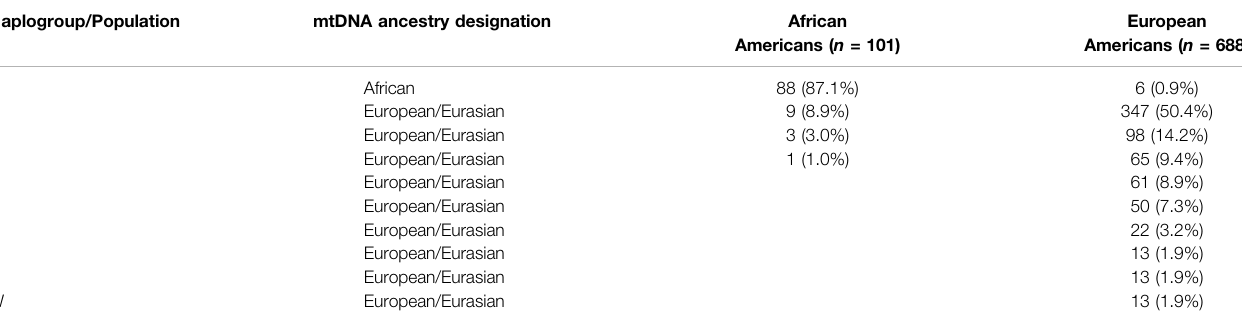
TABLE 1 | MtDNA haplogroup designations for genotyped African Americans and European Americans utilized in the study. The haplogroups are listed in the order of decreasing numbers in the overall dataset. In parentheses is the percentage from the total number of each population. We excluded 29 individuals with non-African or non-Eurasian